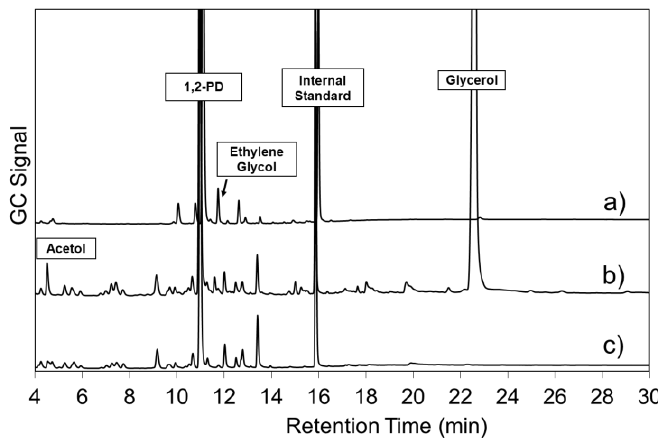
Figure 12. Chromatograms of the final sample of: ( a ) glycerol hydrogenolysis with methanol steam reforming, ( b ) glycerol hydrogenolysis with insufficient molecular hydrogen added, ( c ) acetol hydrogenation. All traces have been displaced for clarity.